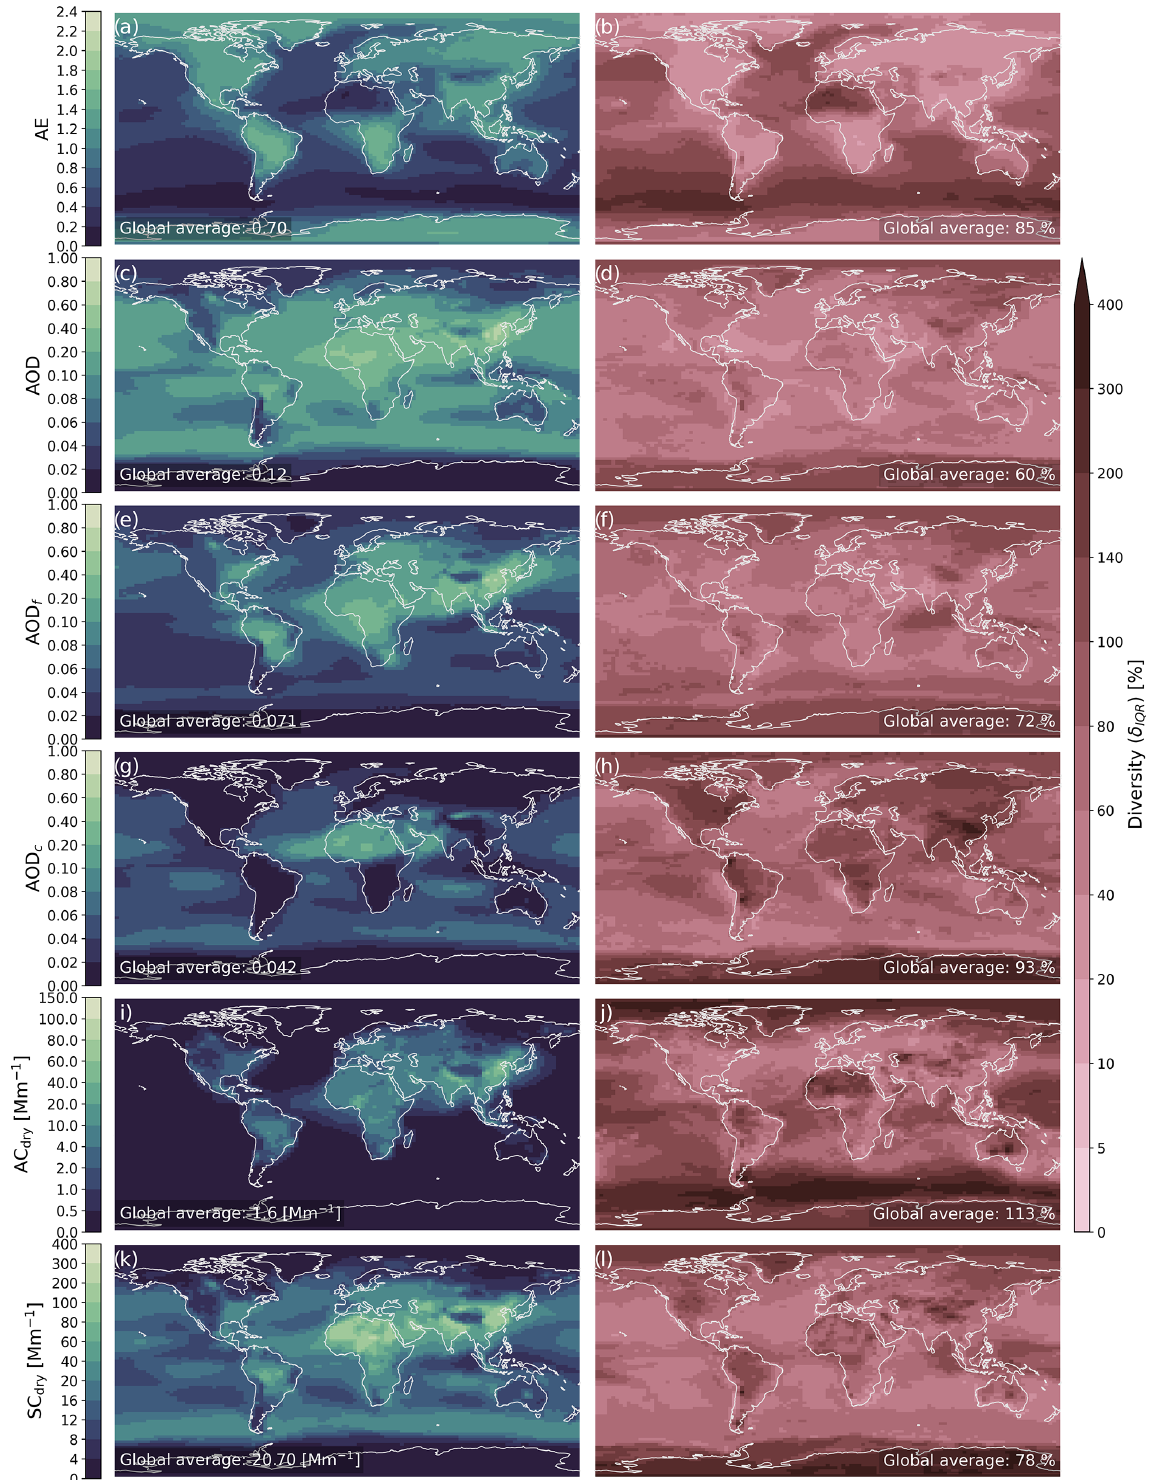
Figure 4. Left: maps showing yearly averages of optical property variables from the AeroCom ensemble median (ENS-MED). The number in the lower left corner of each map represents the yearly global average values from the ensemble. Right: corresponding diversity fields ( δ IQR ) for each variable, including global average diversity in the lower right